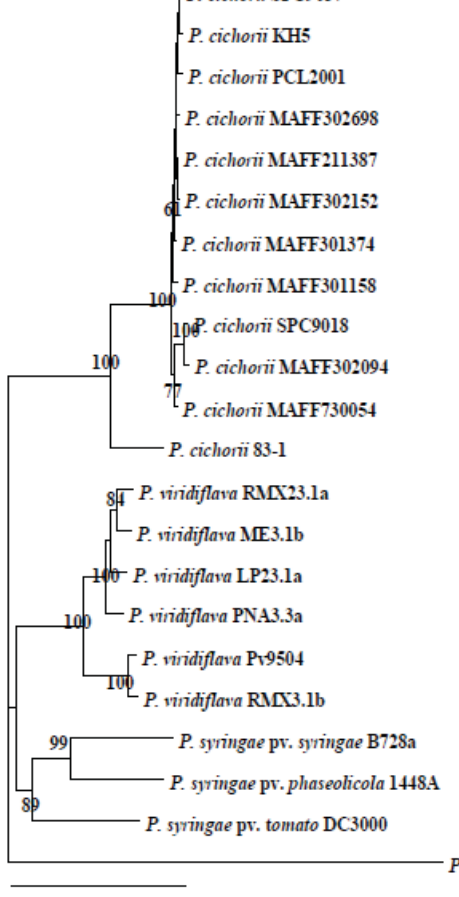
Figure 5. Phylogenetic trees based on the nucleotide sequences of aldH . Phylogenetic trees were constructed using ClustalW (DNA Data Bank of Japan [22]) employing the Neighbor-Joining method [23]. The scale bar indicates a genetic distance, which is the expected number of substitutions per position. The numbers at the nodes represent percentage bootstrap values of 1,000 resamplings that exceeded 60%. The nucleotide sequences of aldH from P. aeruginosa strain PAO1 were used for the phylogenetic tree